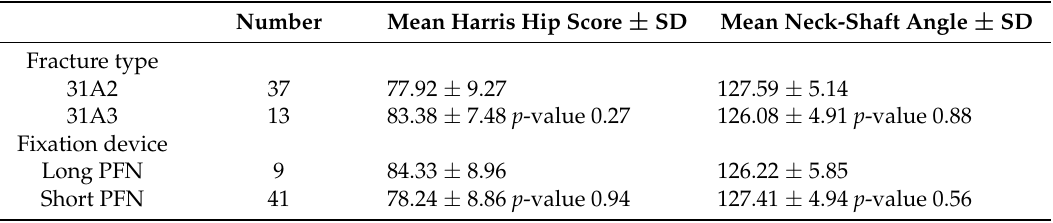
Table 2. Comparisons of final functional and radiological outcomes amongst patients with unstable pertrochanteric fractures who were treated with the